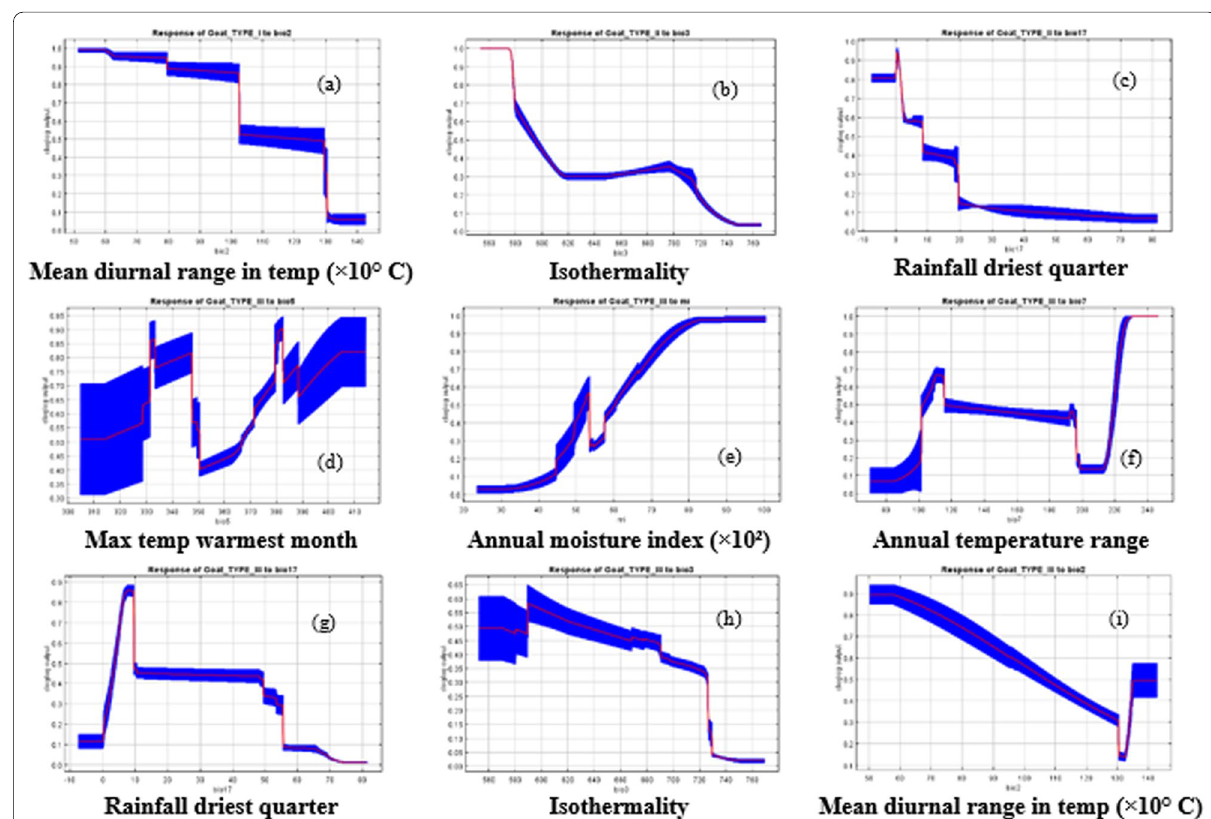
Fig. 7 Response curves for Goat Type I ( a ); Goat Type II ( b ) and Goat Type III ( c ). Distributions showing the relationships between the most important bioclimatic variables and the occurrence